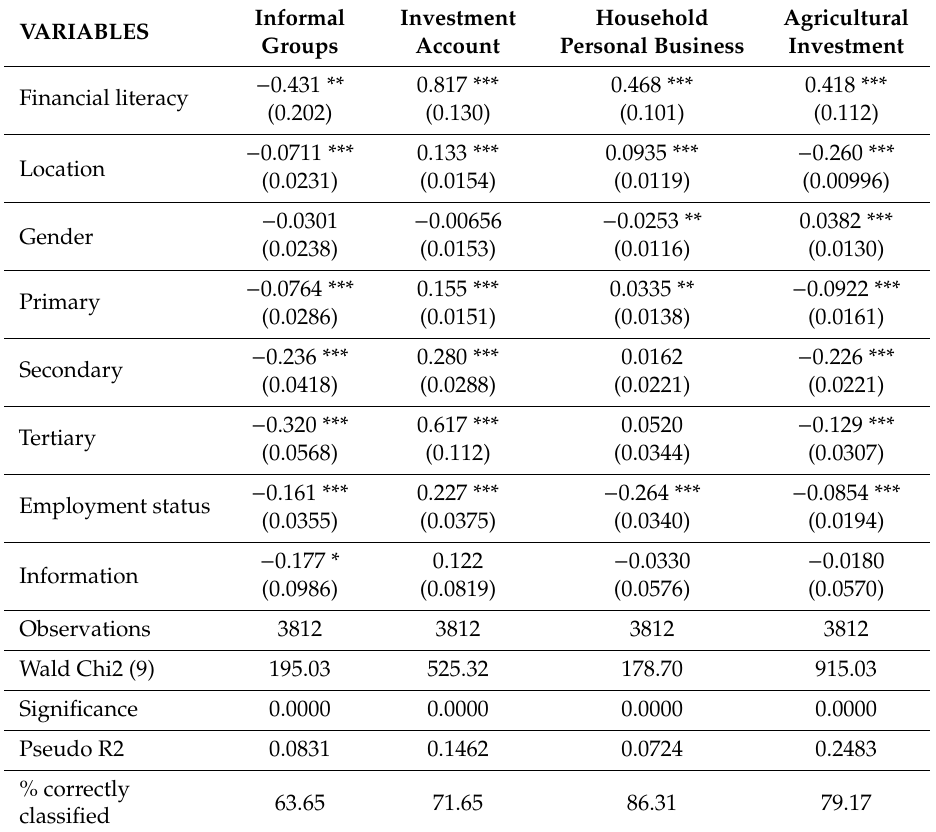
Table 2. Probit Regression